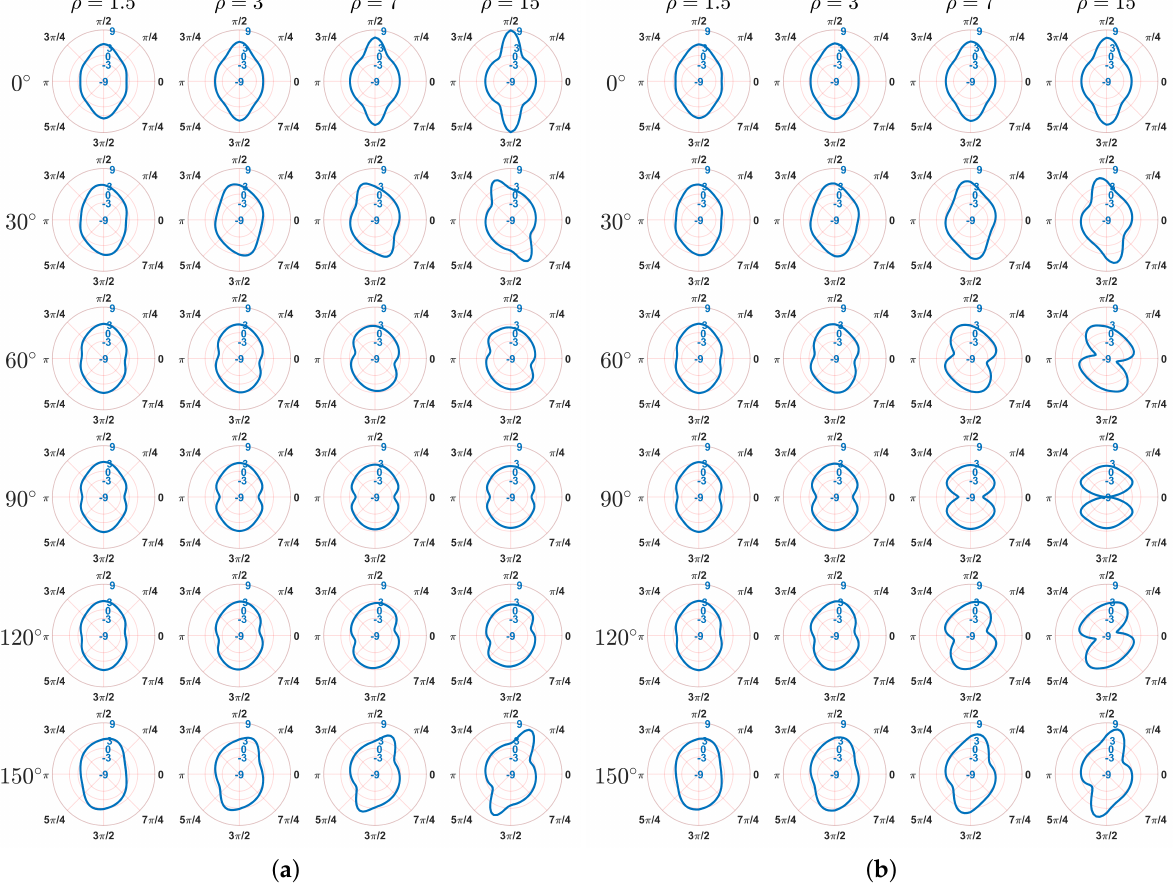
Figure 8. Distribution of the hoop stress σ h at the hole boundary, MPa, ( a ) Cosserat, ( b ) Cauchy. For the orthotropic materials, the distribution of σ h is symmetrical along the vertical direction ( π /2 − 3 π /2) in the polar coordinate. The highest σ h can be observed at the top and bottom points of the hole boundary (i.e., polar angle equals to π /2 and 3 π /2) for the Cosserat model and Cauchy model when β = 0 ◦ , indicating that the peak stress results from the horizontal stress σ 11 . As for the Cauchy model when β = 90 ◦ , it is consistent with the above results for small ρ . As ρ increases, the highest σ h trend to be occurred at the right and left points of the hole boundary (i.e., polar angle equals to 0 and π ). Since